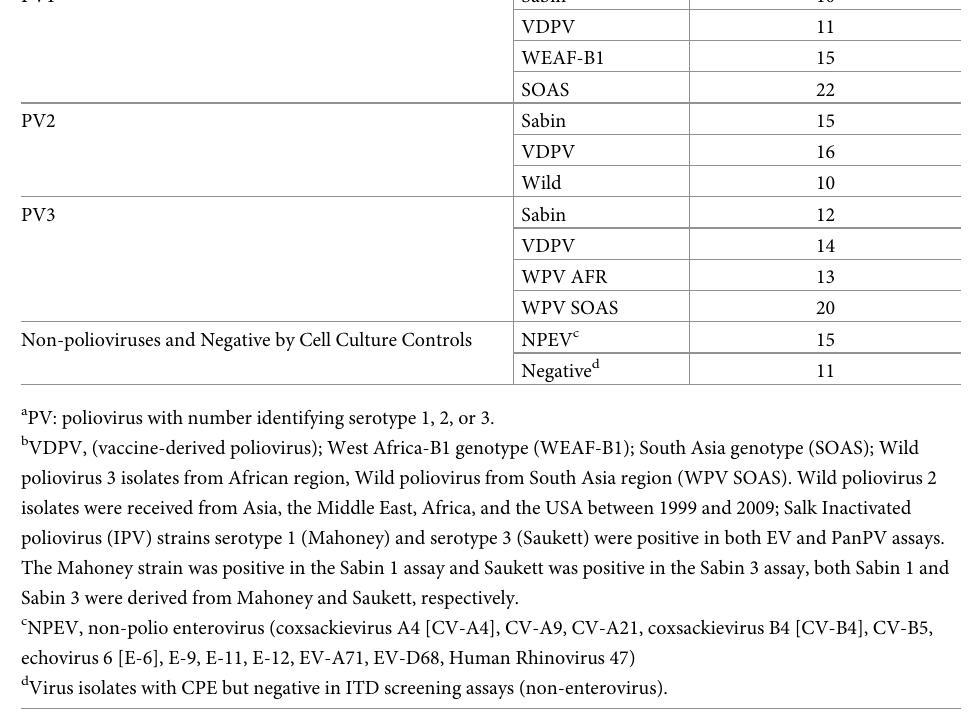
Virus isolates with CPE but negative in ITD screening assays